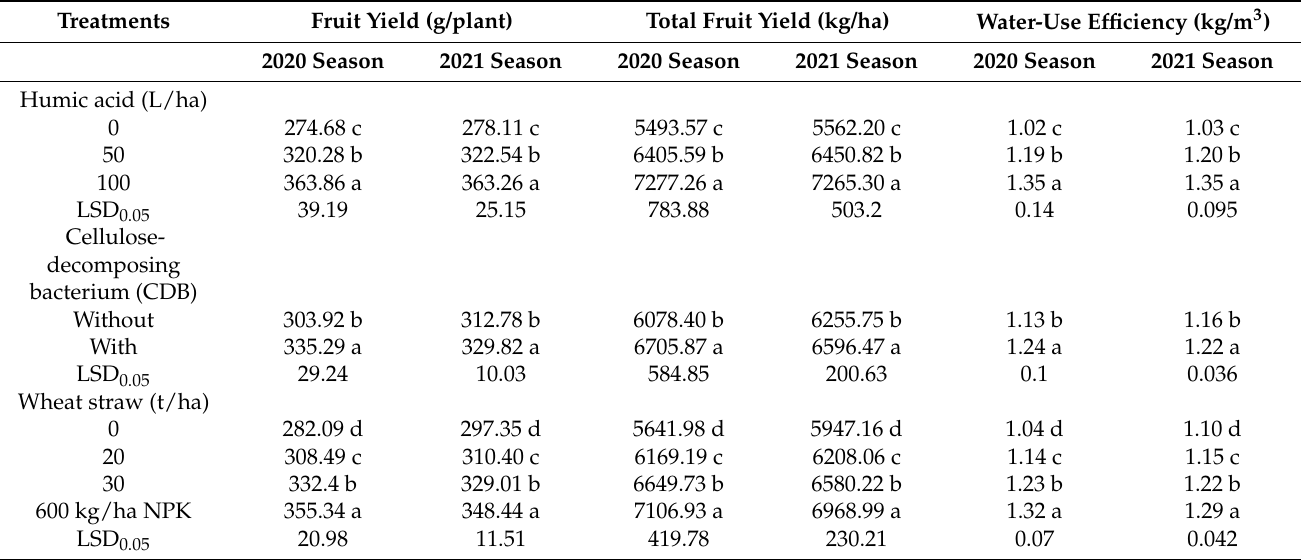
Table 2. Effects of humic acid, cellulose-decomposing bacterium and wheat straw levels on the yield of squash fruit and water-use efficiency during 2020 and 2021 planting seasons. Treatments Fruit Yield